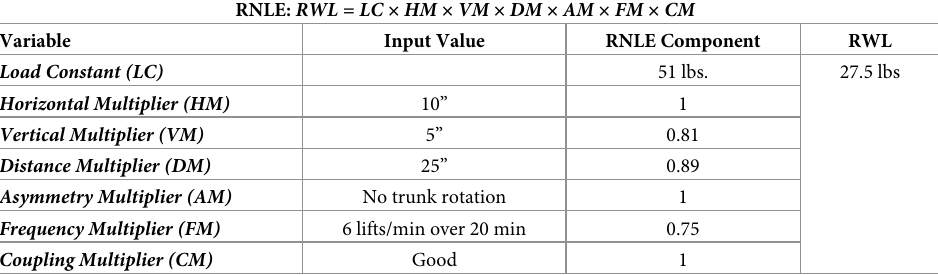
Table 1. Summary of RNLE component. The RNLE computes the RWL for a manual lifting task based on a specific variable that reflects the work geometry and lifting frequency of that particular task. These input values correspond to a RLNE multiplier, which is directly used in the RWL calculation